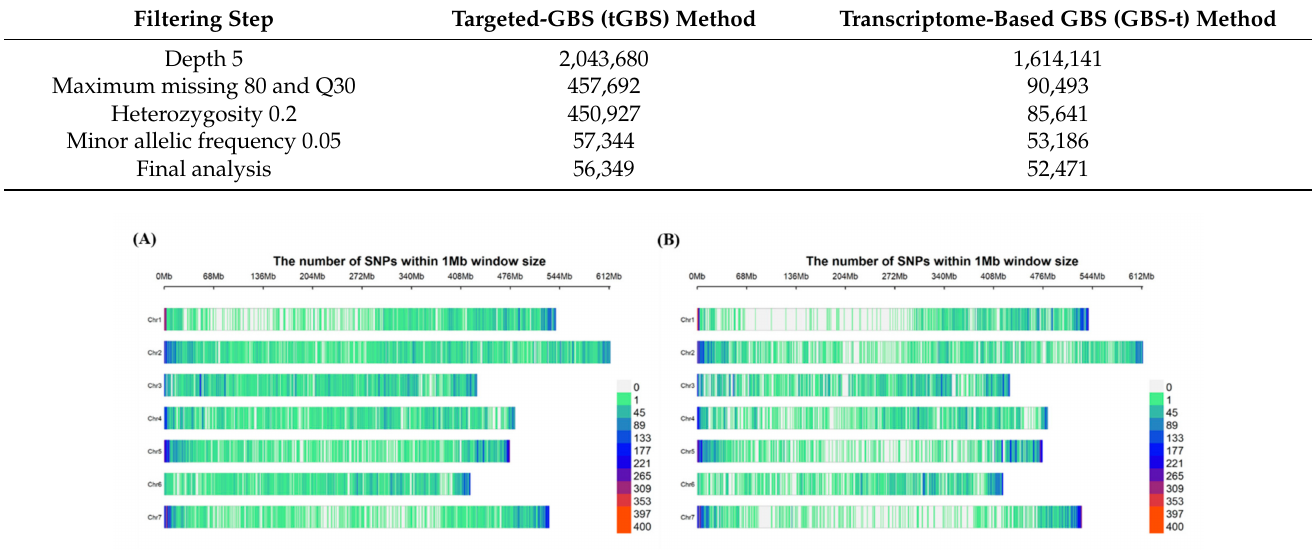
Figure 1. Distribution of SNP markers within 1Mb windows for seven chromosomes (Chr) in lentil ( A ) tGBS method ( B ) GBS-t